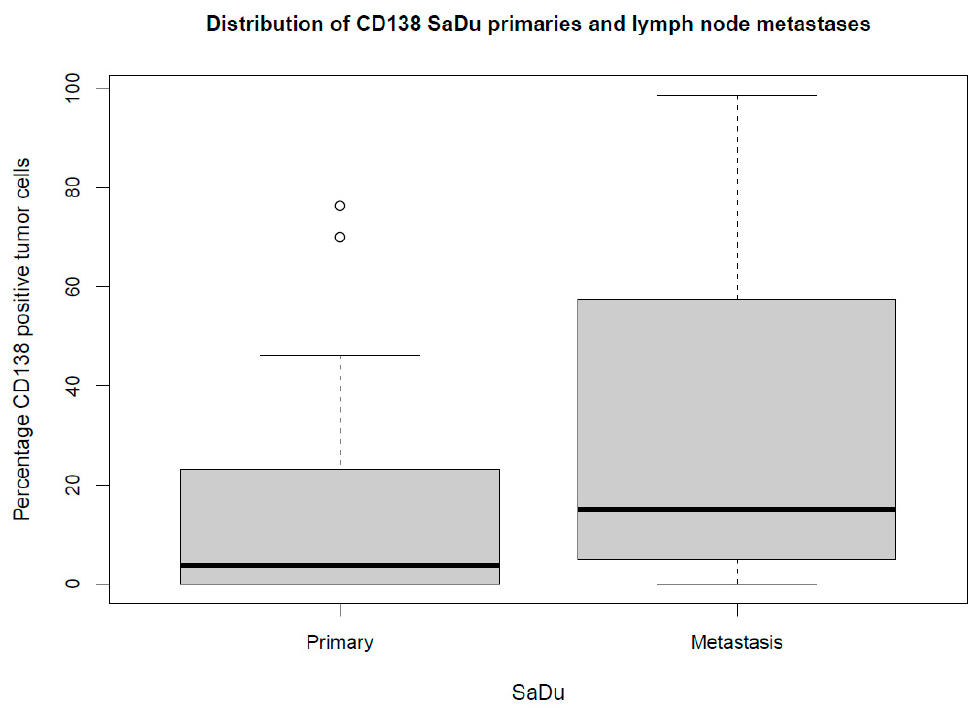
Figure 4. Box plot displaying the distribution of the percentages of CD138-expressing tumor cells for salivary duct carcinoma (SaDu) primaries and lymph node metastases. ◦ Outliers.